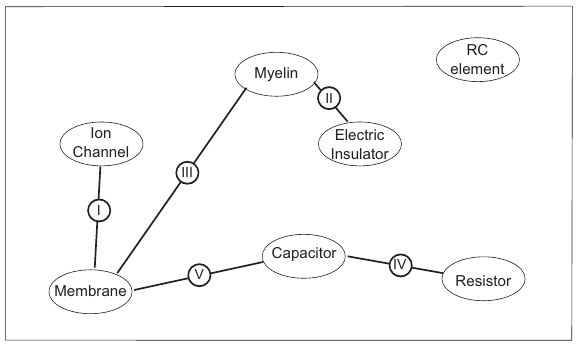
FIG. 6. A concept map, representative for the level of knowl- edge of the control group. The propositions are labeled downward according to their frequency of occurrence (cid:1) I–V (cid:2) .